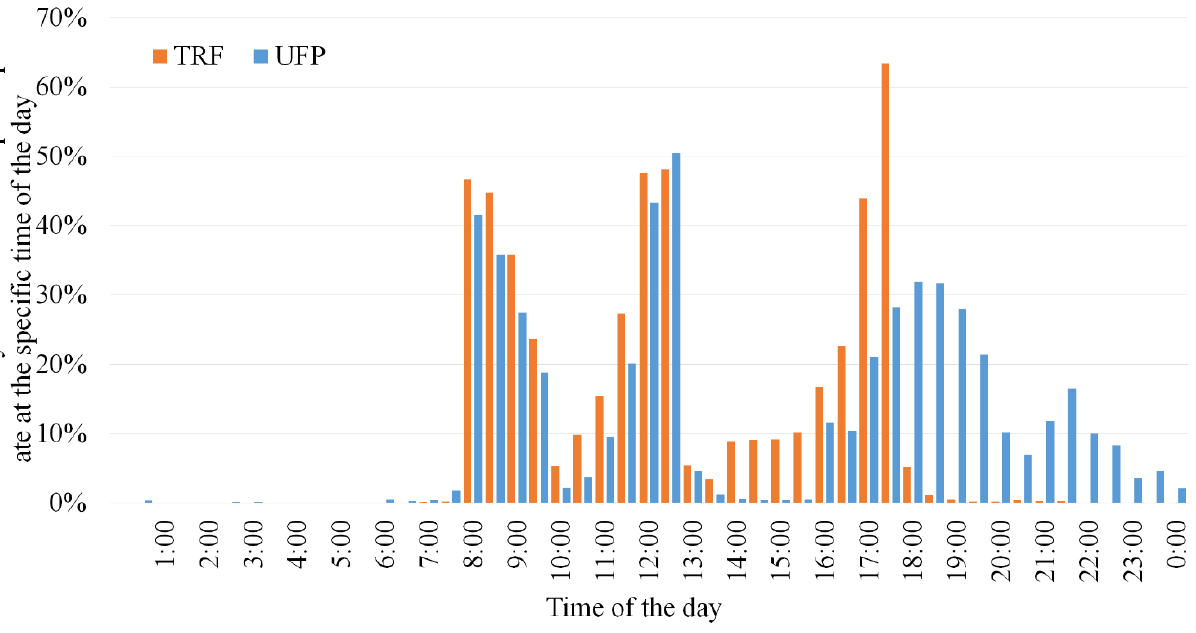
Figure 1. Distribution of meal timing during the study period by study arm. Abbreviations: TRF, time-restricted feeding arm; UFP, usual feeding pattern arm. Table 2. Adherence to meal timing overall and by study arm.